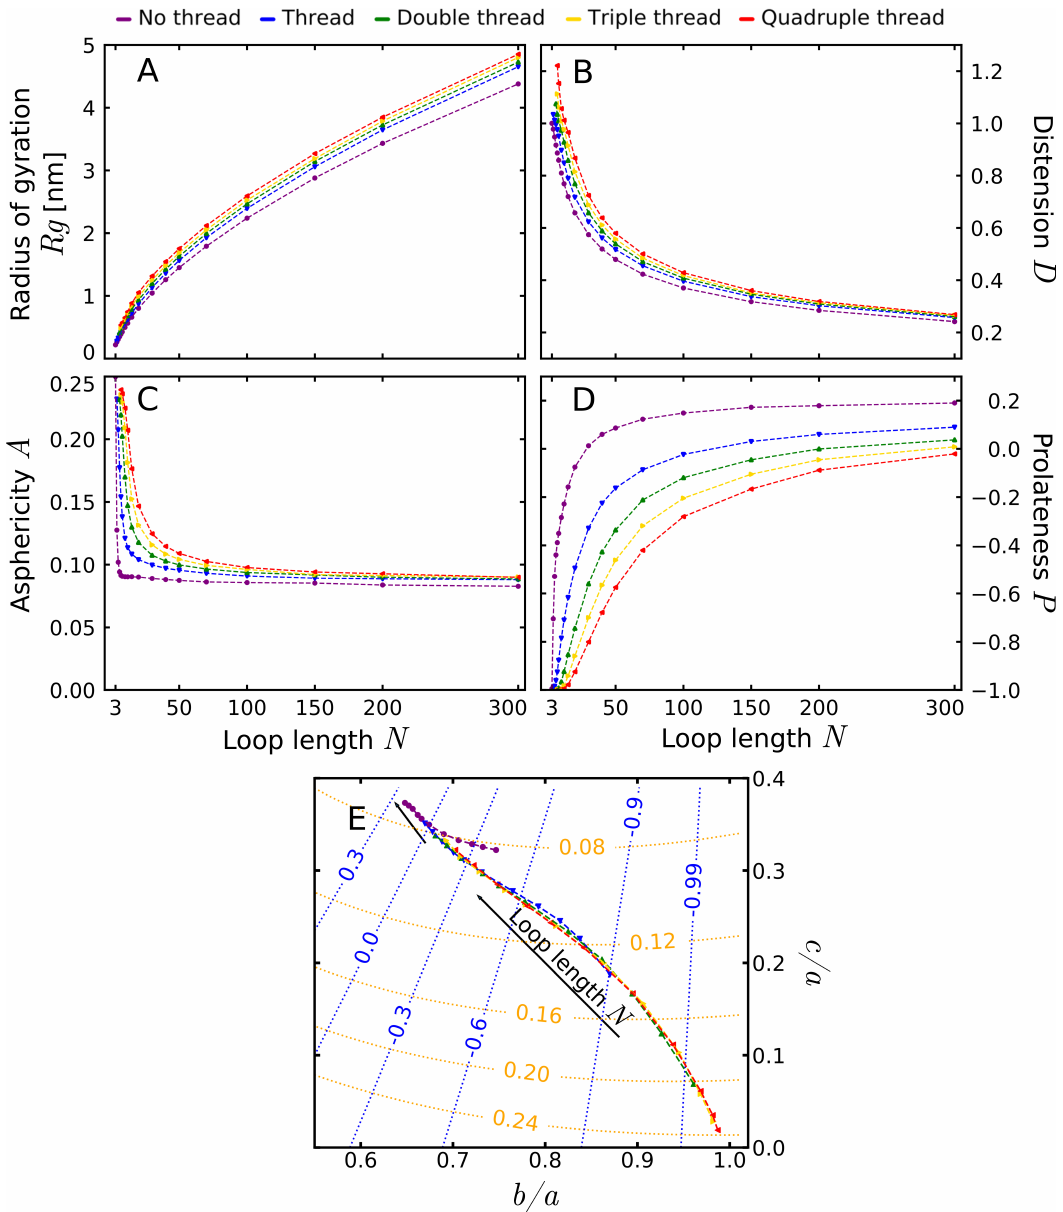
Figure 5. The dependence of shape parameters on the loop length and thread thickness. ( A ) Radius of gyration; ( B ) Distension; ( C ) Asphericity; ( D ) Prolateness; ( E ) The trajectories of the loop shapes in the space of the fraction of ellipsoid semi-axes a > b > c . The traces start from the loops with at least 8 beads. The contour lines of asphericity (orange) and prolateness (blue) were added. Note that the thread thickness determines the smallest possible loop (for details see Materials and